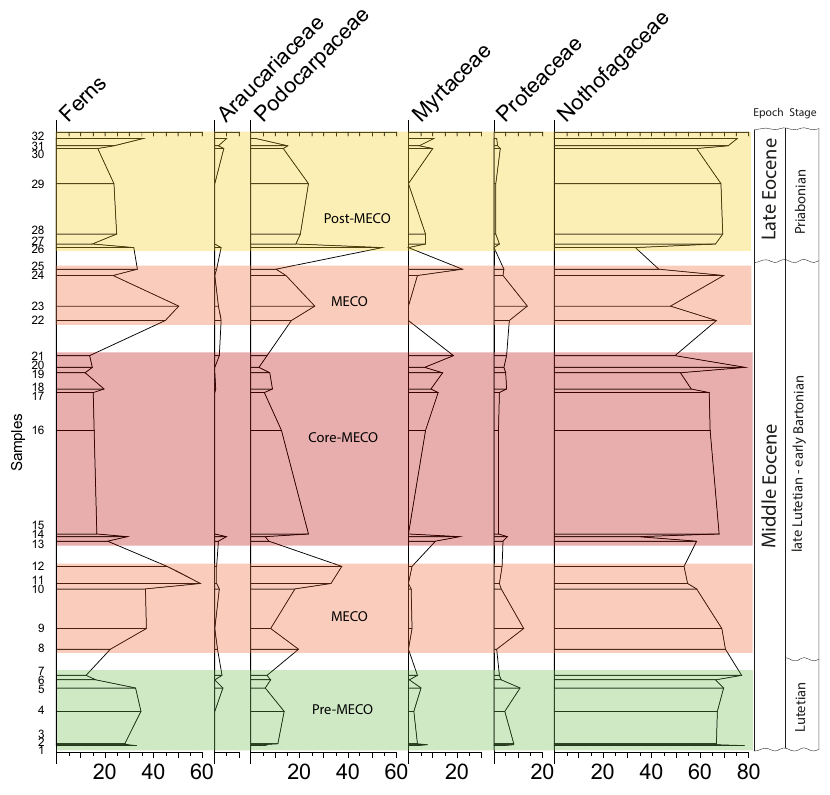
Fig. 6 Relative frequency of the most common plant groups across the recognized intervals. Note the increase in abundance of Proteaceae and Myrtaceae during the MECO.